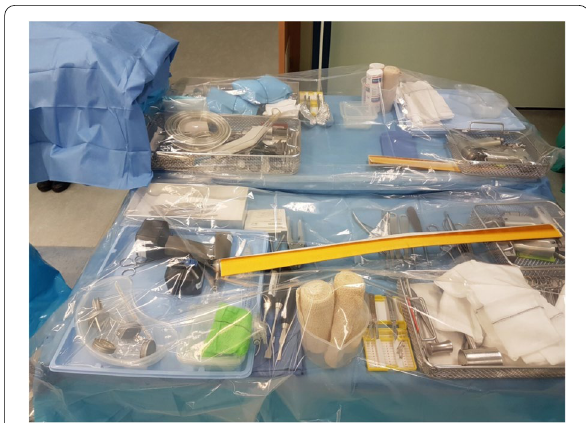
Fig. 4. 2-in-1 single stage revision basic orthopaedic tray setup, consists of two basic trays: 1st basic orthopaedic tray is for implant removal and the 2nd is for re-implantation (plus revision trays as necessary). Please note that the tray at the front is the implant removal tray (5 specimen pots, multiple instruments for intraoperatve